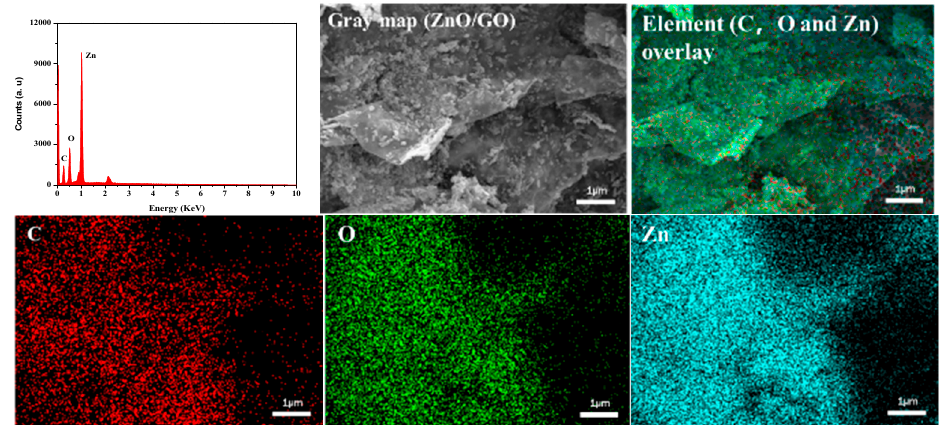
Figure 2. X-ray spectroscopy (EDX) analysis of ZnO/GO.